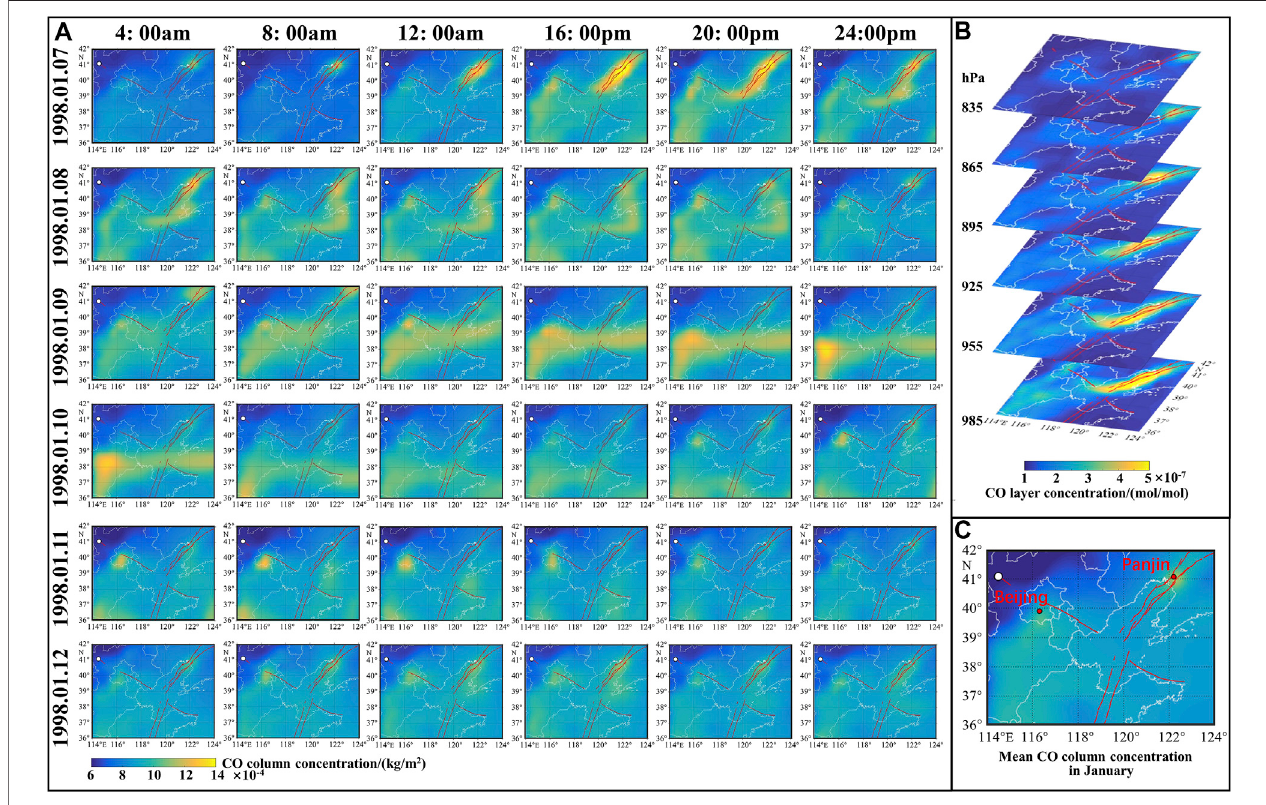
FIGURE6|(A) ThechangeofCOcolumnconcentrationoverBohaiSeafrom7to12January1998. (B) ThechangeofCOlayerconcentrationfrom18:00to21:00 on 7 January 1998. (C) The mean CO column concentration in January of non-seismic years from 1993 to 2003.